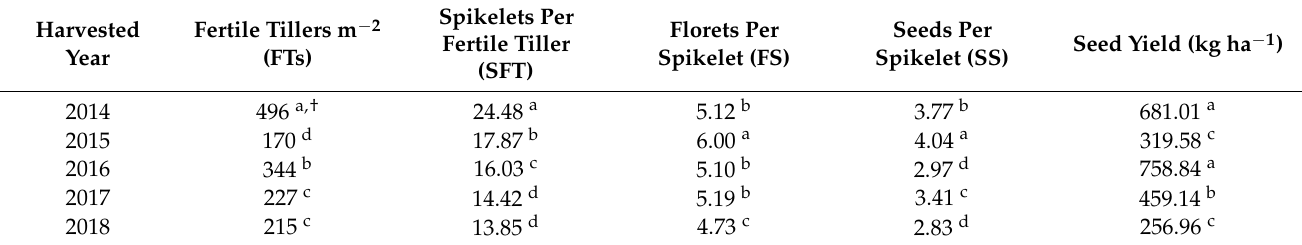
Table 4. Changes in seed yield and seed yield components of smooth bromegrass from 2014 to 2018. Spikelets Per Harvested Fertile Tillers m − 2 Year